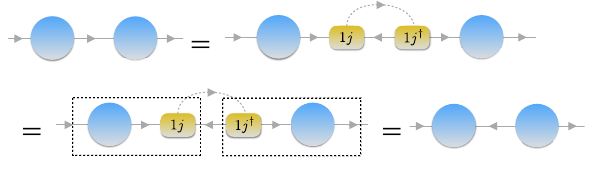
Figure 5: Arrow inversion. An identity, (cid:73) = U † U , is inserted on a bond (here the center bond) where up to normalization the unitary U represents a 1 j symbol [ 31 ] , i.e., a (degenerate) rank-3 tensor which combines two state spaces, q and its dual ¯ q into a scalar singlet state. Upon absorbing U and U † on opposite sides with the neighboring tensors, effectively, the arrow on the center bond has been reverted. The singlet index (dashed line) can be omitted in the end.